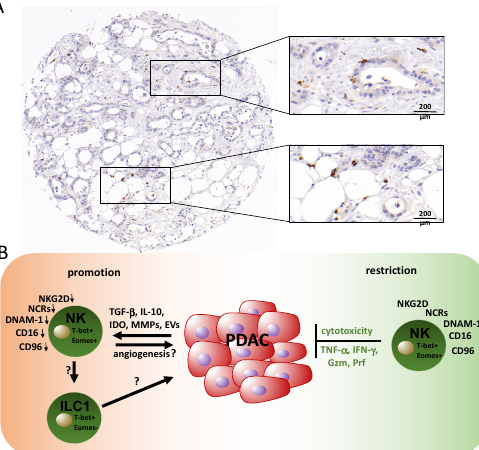
Figure 2. Natural killer cells and their roles in PDAC. ( A ) Immunohistochemical staining of CD56 reveals disseminated natural killer (NK)/NKT (Natural killer T-cells) cells (brown). The depicted case shows a rather high density of NK cells considering the distinct heterogeneity of NK cell infiltration, which is generally low in PDAC tissue. ( B ) PDAC NK cells isolated from the periphery are characterized by a reduced expression of cytotoxicity receptors and exhibit impaired anti-tumor activity, which is induced by mediators of the tumor microenvironment. Restoration of NK cell functions is possible, e.g., via ex vivo activation with IL-2 and gamma-irradiated feeder cell lines. The phenotype of tumor-infiltrating NK cells or other innate lymphocytes such as ILC1 cells and their activity is poorly understood. Gzm: granzyme; Prf: